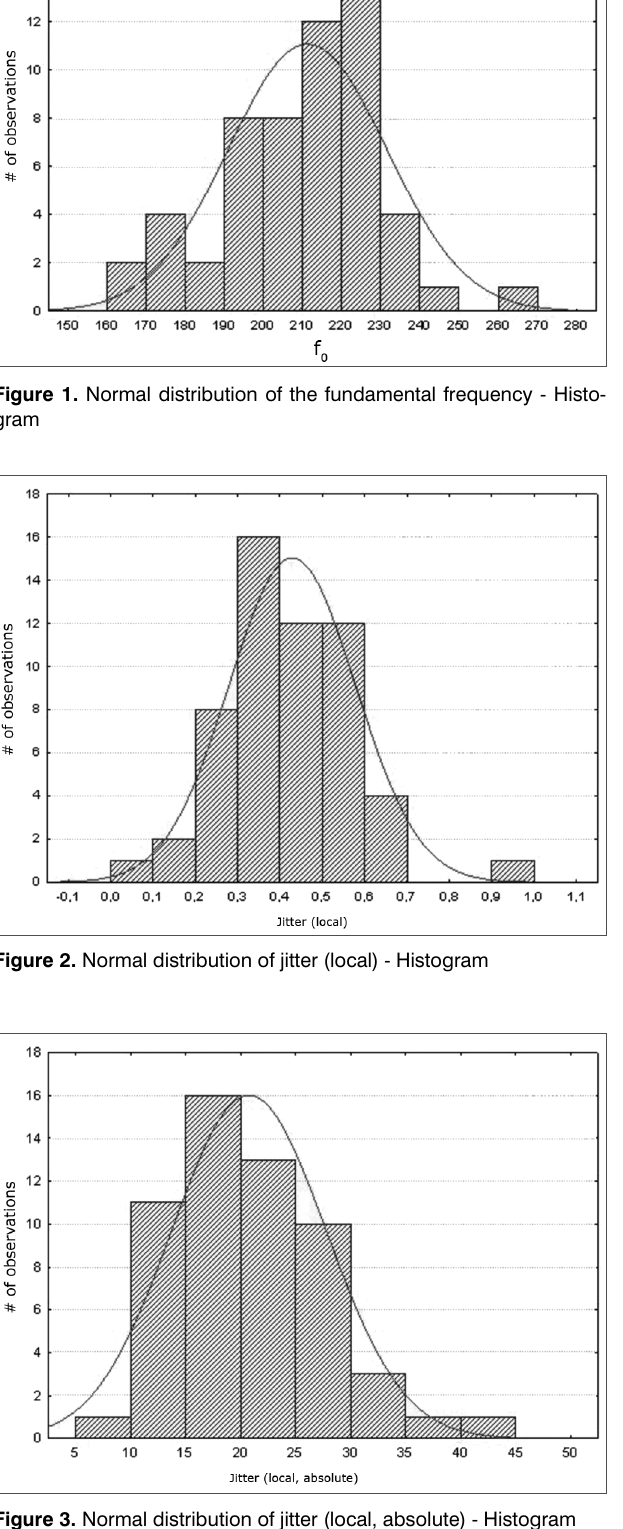
Figure 3. Normal distribution of jitter (local, absolute) - Histogram